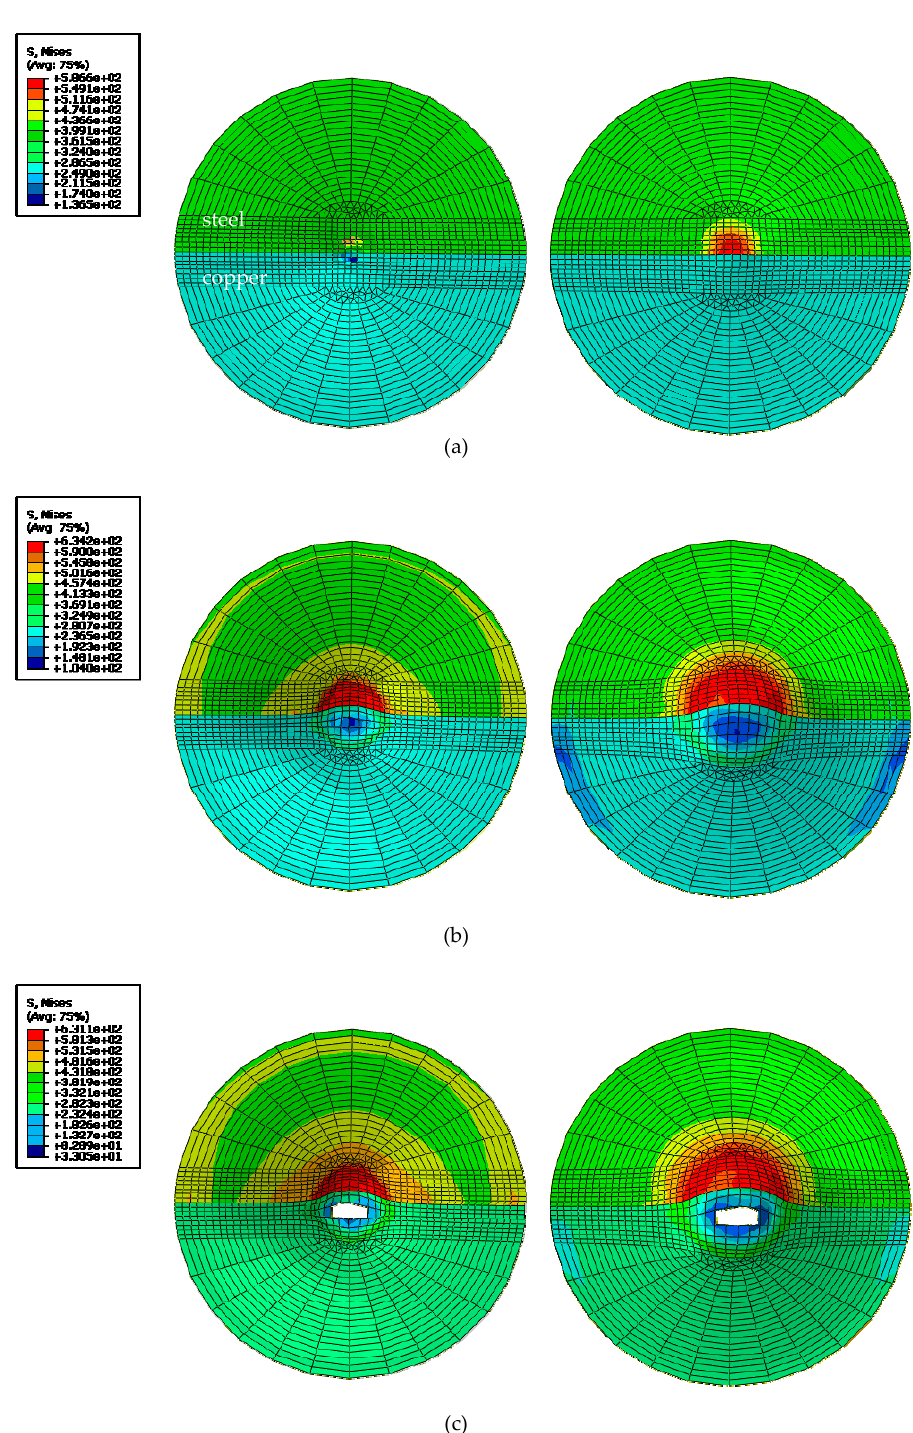
Figure 11. The SPT fracture simulation: ( a ), the initial stage, ( b ) the middle stage, ( c ) the initial cracking stage.